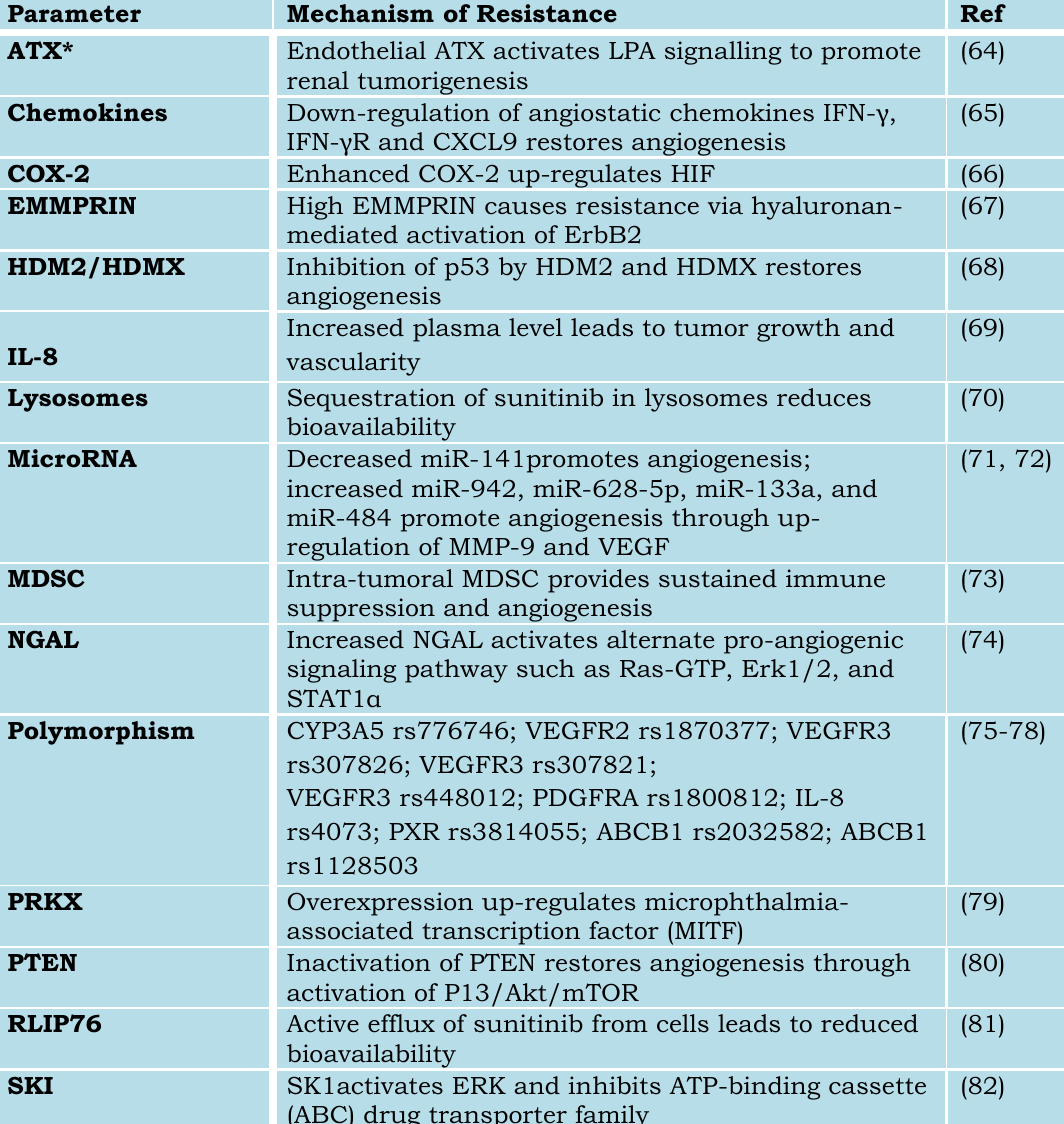
Table 1. Emerging mechanisms of resistance to sunitinib